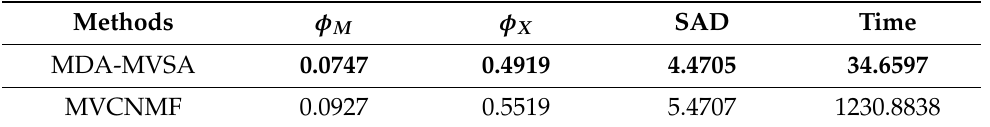
Table 7. Performance and processing time (in seconds) obtained by our proposed MDA-minimum volume simplex analysis (MDA-MVSA) method and minimum volume constrained nonnegative matrix factorization (MVCNMF) on the considered Cuprite